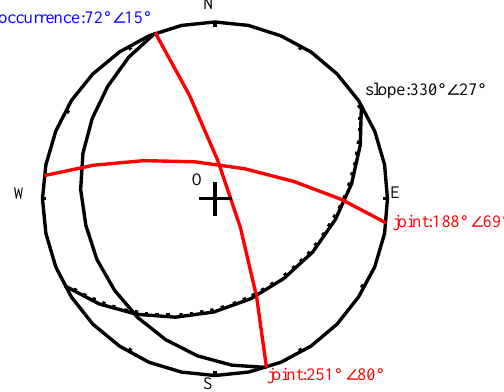
Figure 2. Diagram of the stereographic projection.